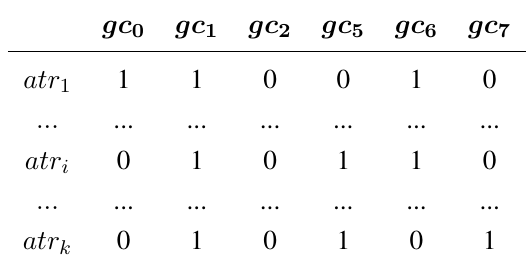
Table 4. An example of the GC-SNCache table, where gc atr specifies the j -th attribute. The value 1 means that sensory data for a certain grid cell j (e.g., gc ) with a certain attribute (e.g., atr 1 means they are